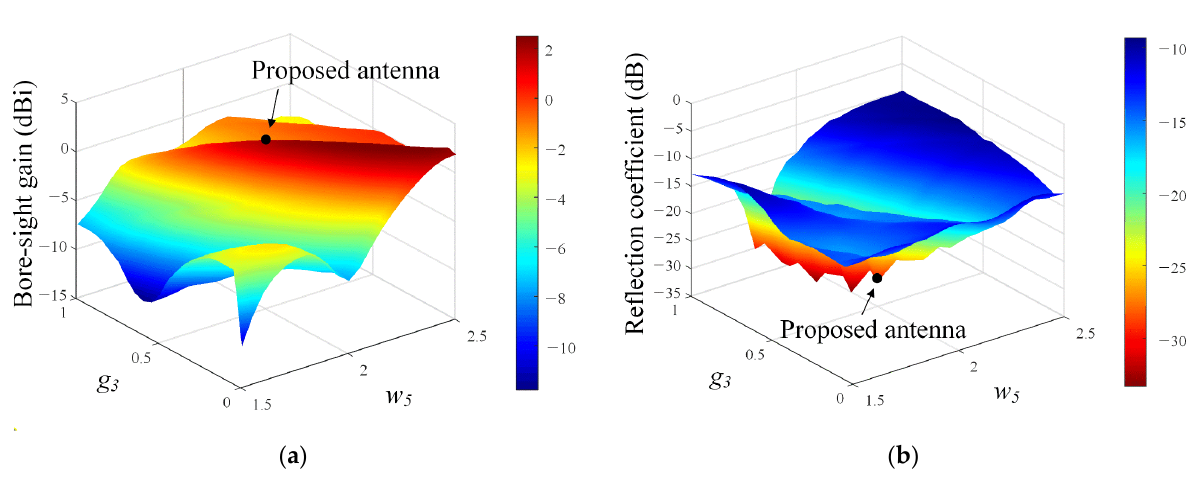
Figure 10. Bore-sight gain and reflection coefficient in accordance with the variations of parameters w 5 and g 3 : ( a ) bore-sight gain; ( b ) reflection